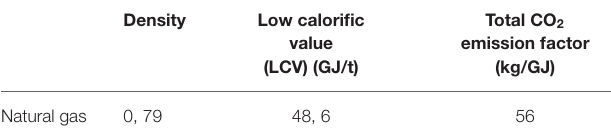
TABLE 1 | Data for NG used in the